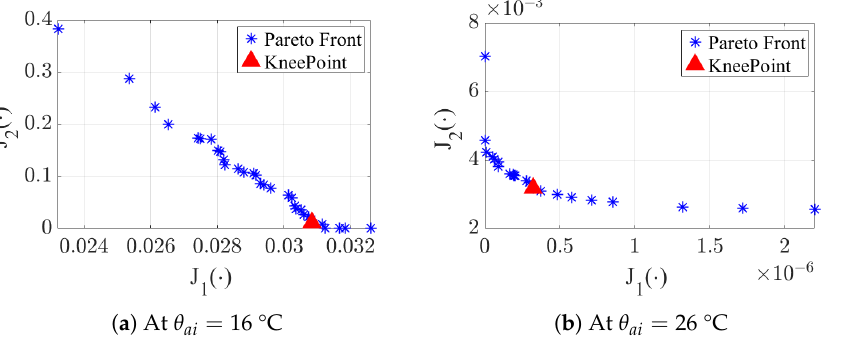
Figure 9. Pareto optimal fronts generated at minimum (16 °C) and maximum (26 °C) outside temperatures θ ai recorded during summer.